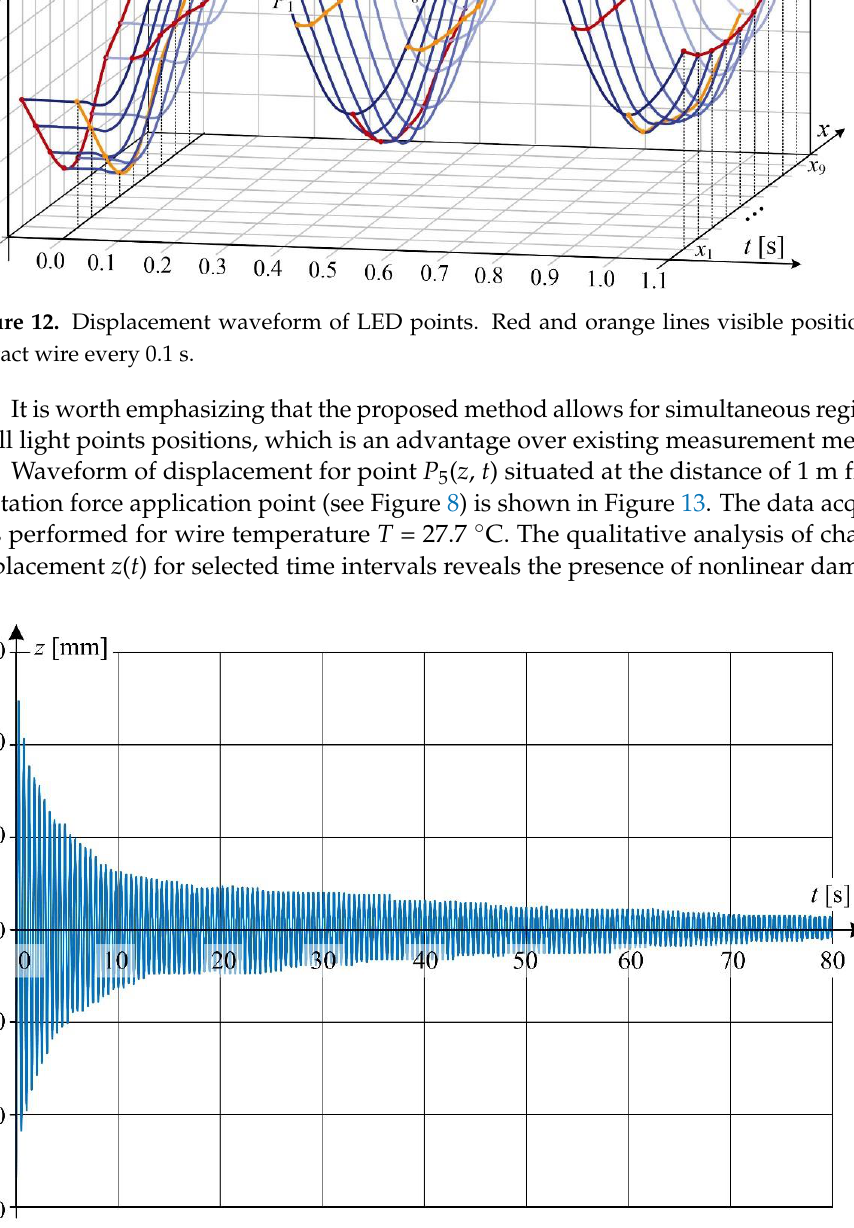
Figure 13. Displacement waveform of LED point P 5 ( z , t ) for wire temperature 27.7 °C.